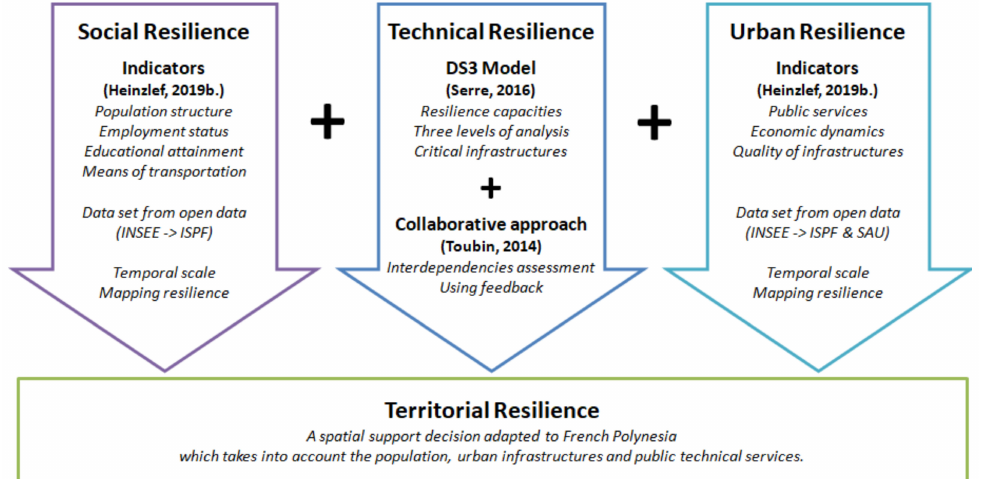
Figure 2. Combination of the three selected models and their adaptation to the evaluation of territorial resilience in French